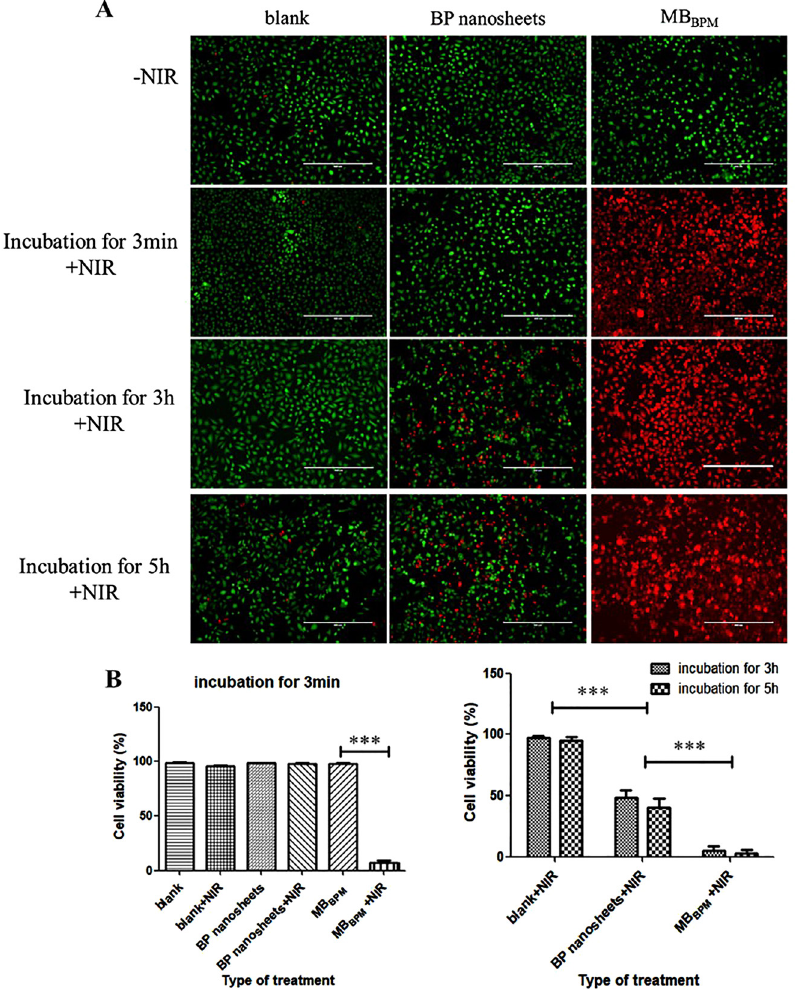
Figure 10: (A) The fluorescence images of the MCF-7 cancer cells treated with BP nano- sheets, MB BPM , or none of them (blank) without or with NIR laser irradiation after incubation for 3 min, 3 h, or 5 h and then stained with calcein AM (green) and PI (red) for live and dead cells, respectively. (B) The corresponding relative viability of the treated MCF-7 cancer cells. The scale bar is 400 μ m. Data represent mean with SD, n = 5. * p < 0.05, ** p < 0.01, *** p <